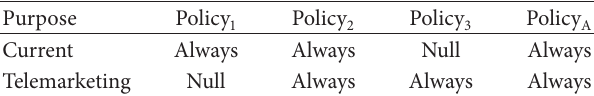
Table 3: Optional values of Data elements in Service A. Data Policy User.name